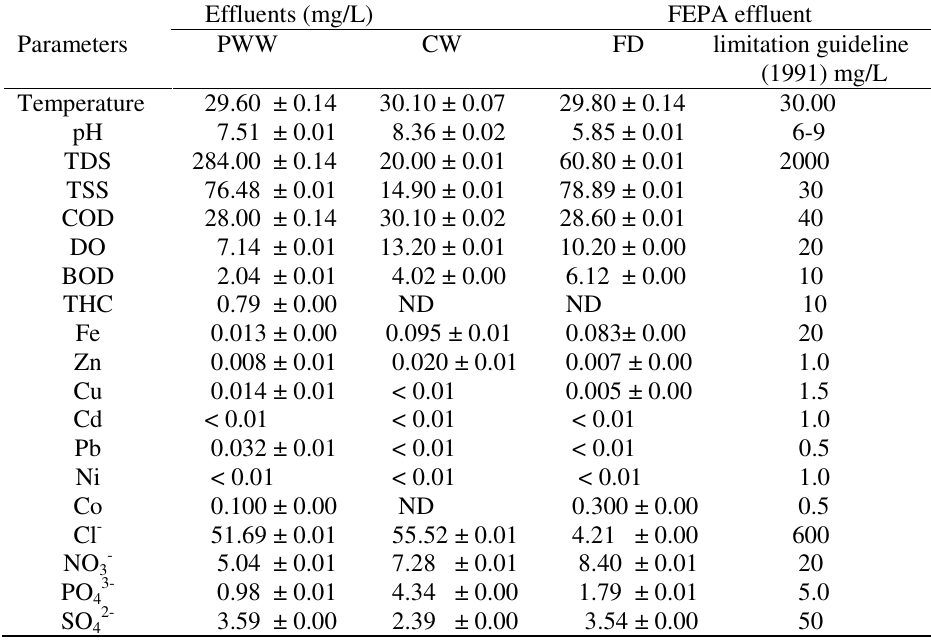
Table 1. Physicochemical parameters and some metal/non-metal ions concentration in effluent samples of Eleme Petrochemical Company compared with FEPA